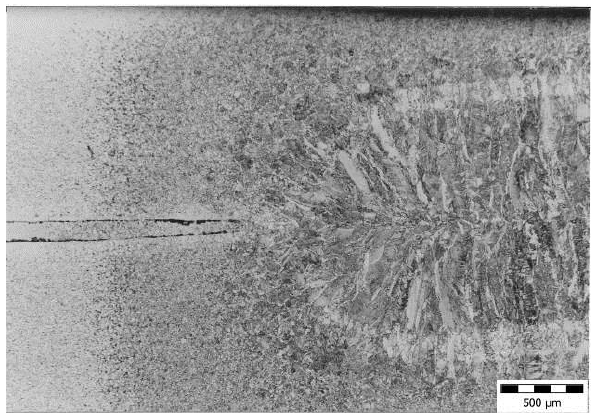
Figure 6: Microstructure of transition from the base metal to the weld nugget in sample A.